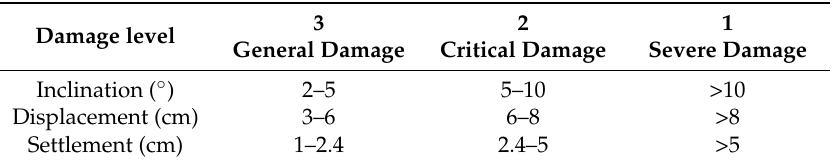
Table 4. The empirical criteria for the damage level evaluation of the spur dike